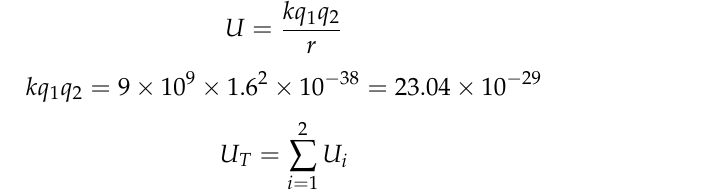
Figure 12. Proposed 1 × 2 CAM circuit.